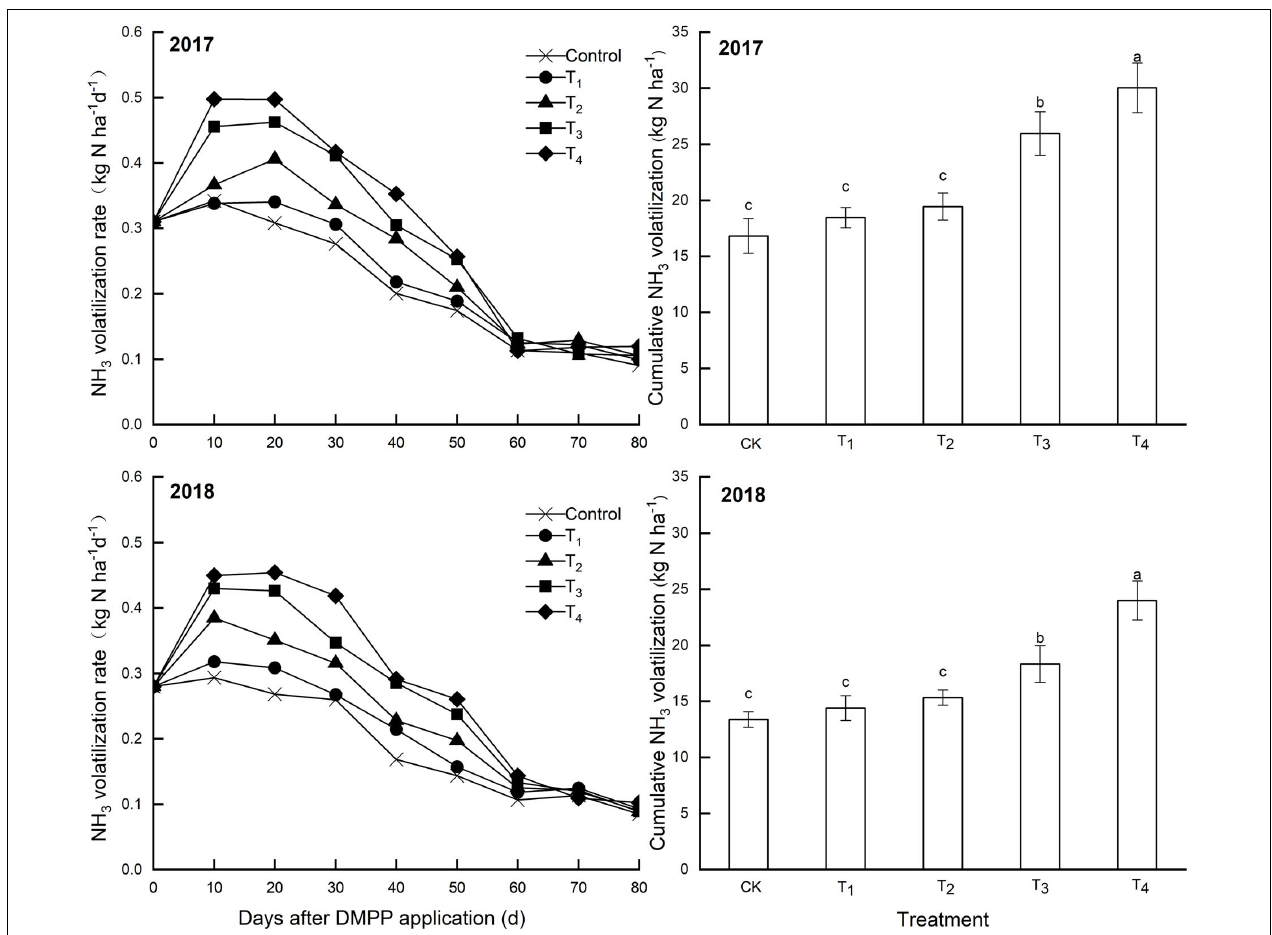
FIGURE 5 | Effects of DMPP on the NH 3 volatilization rate and cumulative NH 3 volatilization in 2017 and 2018. The vertical bar indicates the standard deviation of three replications. Different letters indicate statistically significant differences ( P <